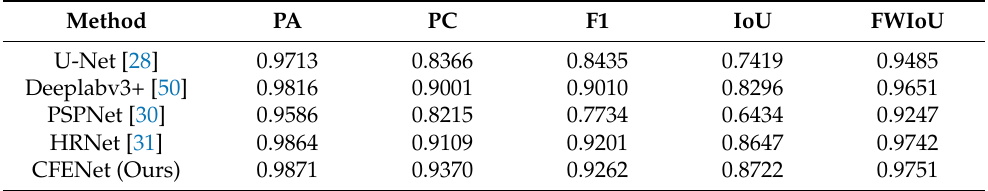
Figure 7. Results of different methods on easily confused buildings. ( a – c ) Original input images; ( d ) ground truth; ( e – i ) the results of our method and the other four methods, respectively. Green, red, and blue pixels on the map represent predictions of true positives, false positives, and false negatives, respectively. The experimental results in the red box show the areas where the contrast effect is more obvious. Table 1. Performance of different methods on the WHU Building